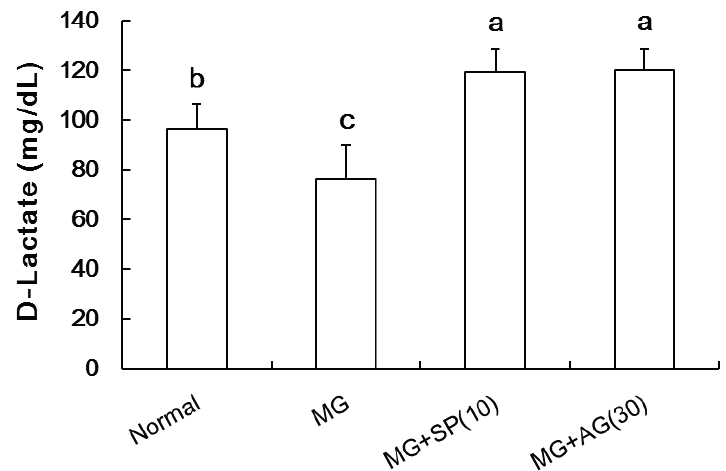
Figure 4. The effects of scopoletin (SP) on serum methylglyoxal (MG) metabolism into D -lactic acid. (a–c) indicate statistically significant differences p < 0.05. Data are presented as mean ± SD ( n = 8/group). Normal: deionized water; MG: methylglyoxal (300 mg/kg body weight); MG + SP (10): methylglyoxal (300 mg/kg body weight) + scopoletin (10 mg/kg body weight); MG + AG (30): methylglyoxal (300 mg/kg body weight) + aminoguanidine (30 mg/kg body